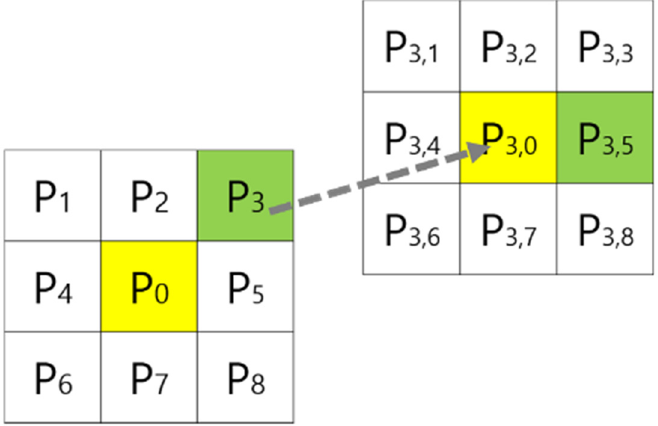
Figure 6. Selection of the cell with the higher weight among neighboring cells.